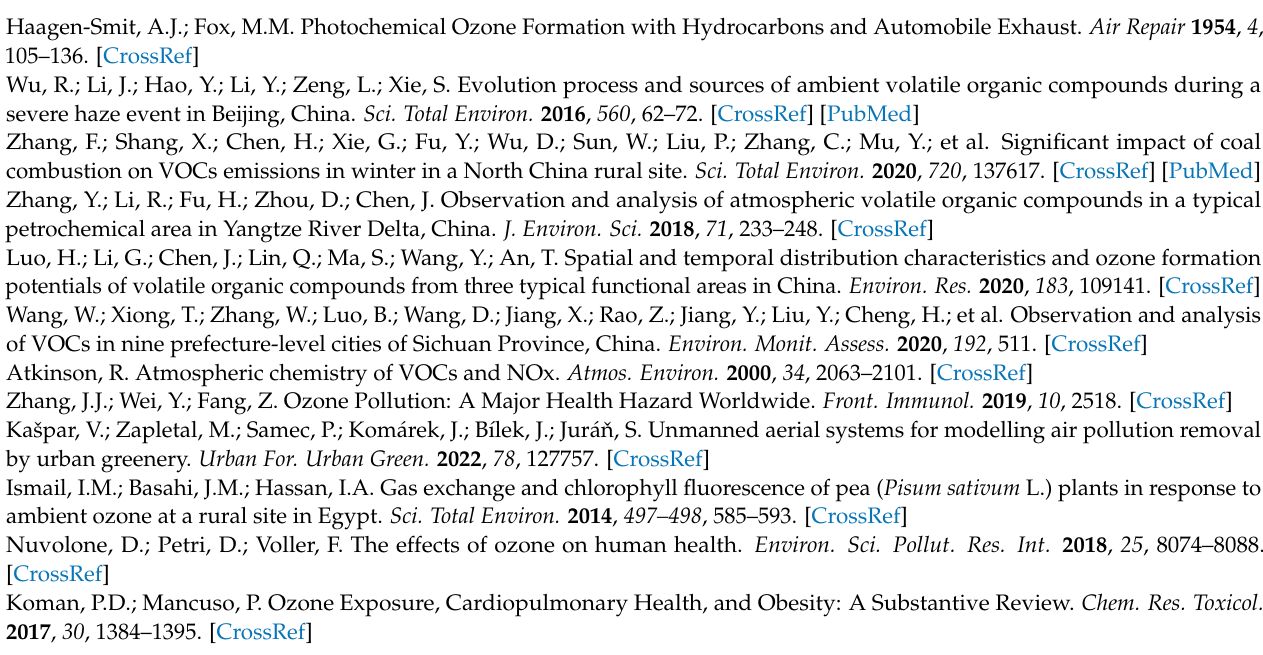
Figure S2: Diurnal patterns of the meteorological parameters and major air pollutants; Figure S3: Scatter plots of calculated LCR/NCR values versus reconstructed values from PMF-MLR analysis; Figure S4: Relative contributions of different sources to the LCR/NCR of compounds